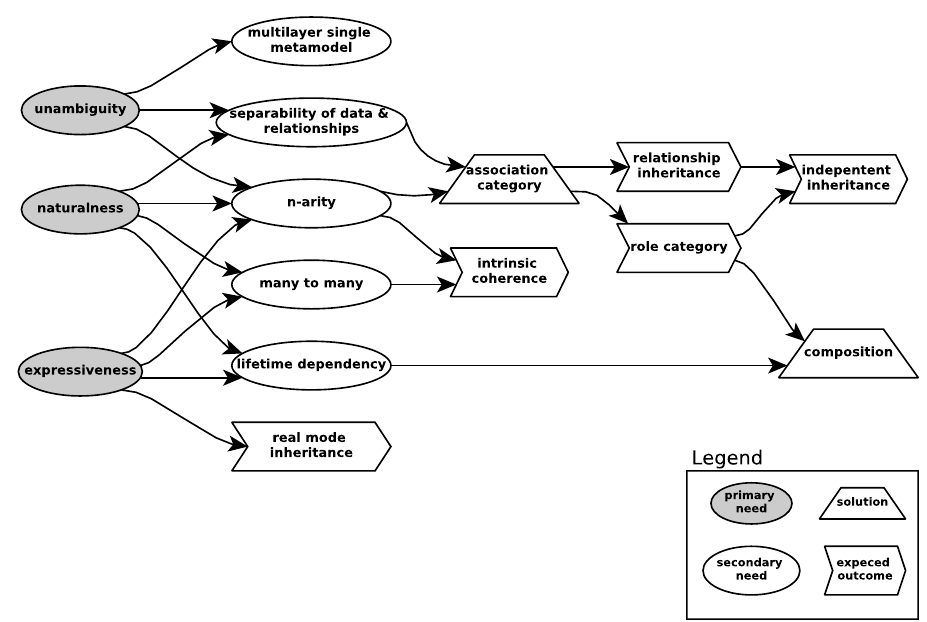
Fig. 1. Directed graph containing a network of interlinked postulates, solutions and e®ects of undertaken